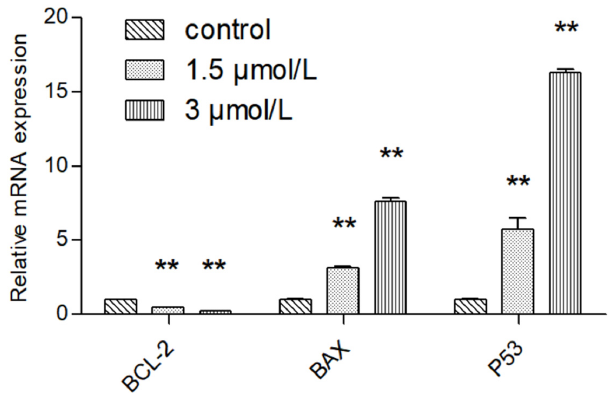
Figure 7. Changes in the expression of mitochondrial apoptosis-related genes BCL-2 and BAX in human normal intestinal epithelial cells NCM460 and colon cancer cells HCT116 and LOVO. n = 3; Compared with the blank group, ** p < 0.01, each data point represents the mean ± standard error.